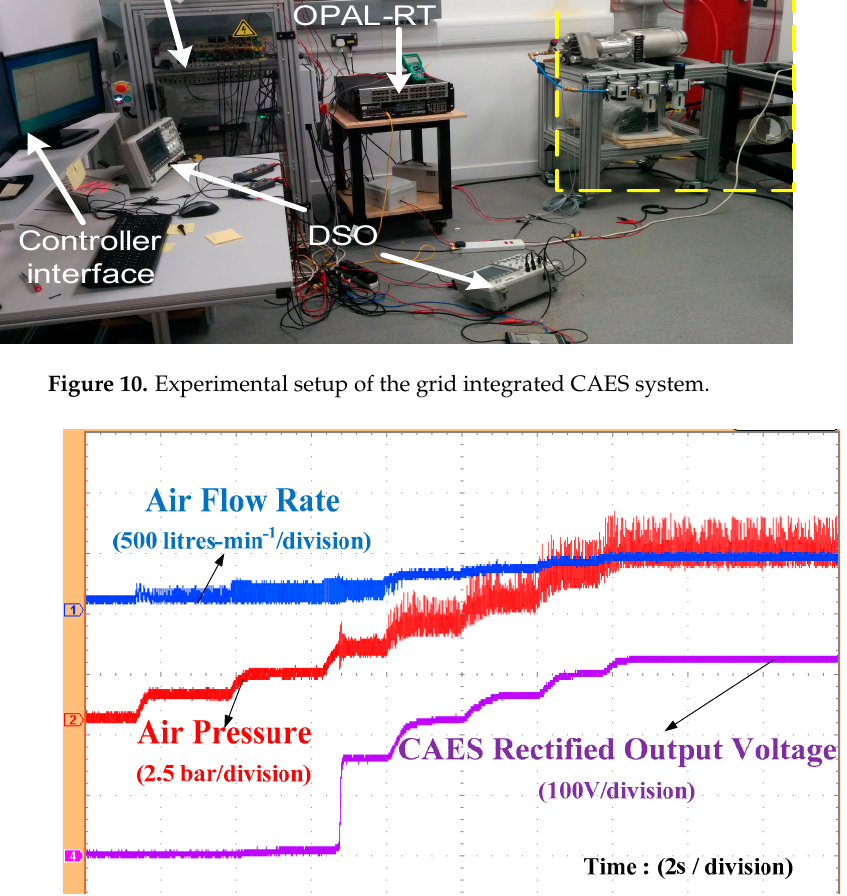
Figure 11. CAES output voltage with different air flow rate and air pressure.